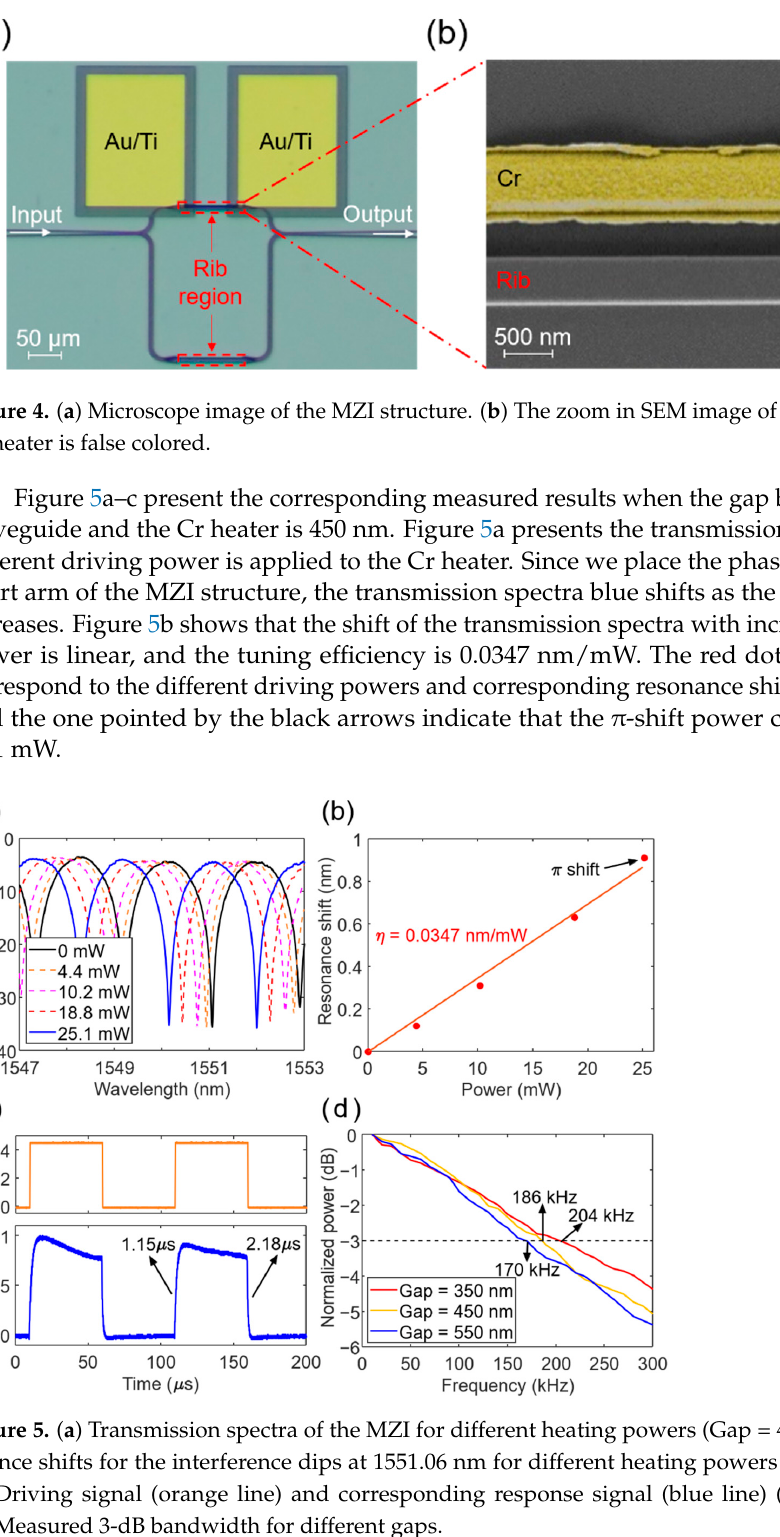
Figure 5. ( a ) Transmission spectra of the MZI for different heating powers (Gap = 450 nm). ( b ) Res- onance shifts for the interference dips at 1551.06 nm for different heating powers (Gap = 450 nm). ( c ) Driving signal (orange line) and corresponding response signal (blue line) (Gap = 450 nm). ( d ) Measured 3-dB bandwidth for different gaps. A 10 kHz square-wave signal (shown as the orange line in Figure 5c) generated by the AWG is used to drive the Cr heater to measure the dynamic response of the phase